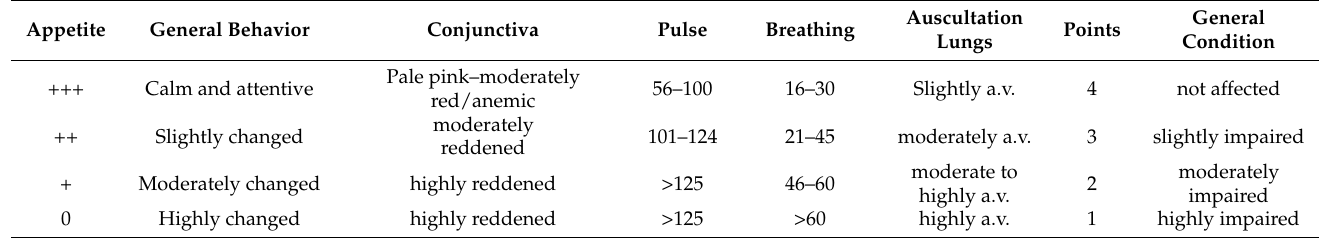
Table 3. Assessment of general well-being after M. agalactiae infection.